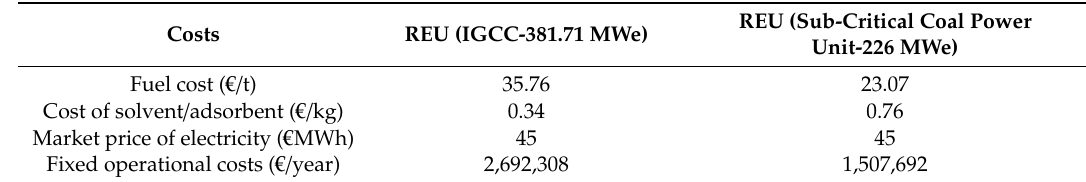
Table 6. Operational expenditures (OPEX) variables for reference energy units (REUs) of both case studies [18,19].